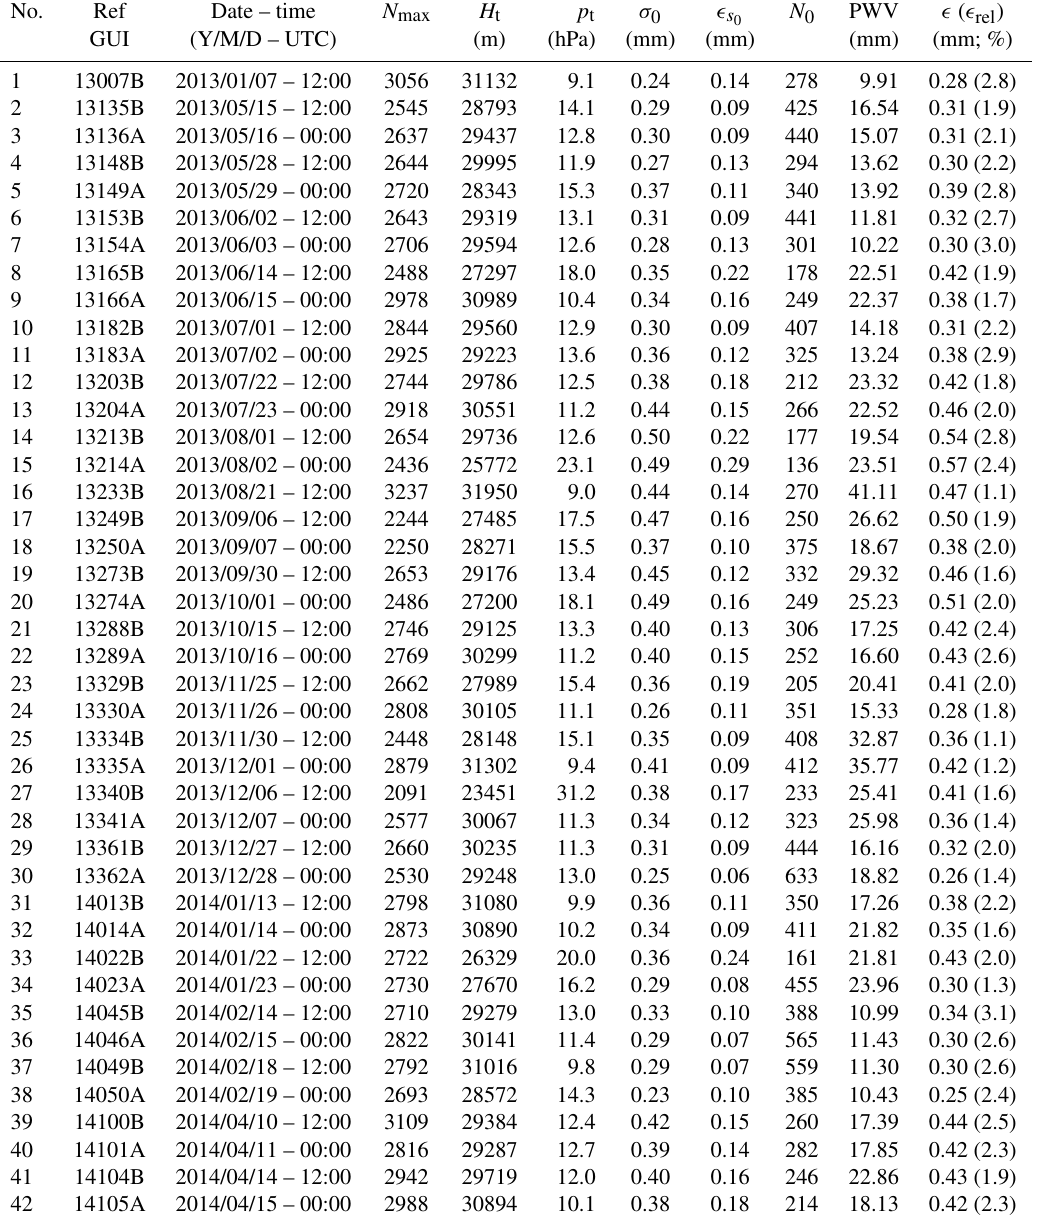
Table B2. PWV data and optimized error (cid:15) (see Eq. 19) from the radiosoundings at GUI. See the caption of Table B1 for description.